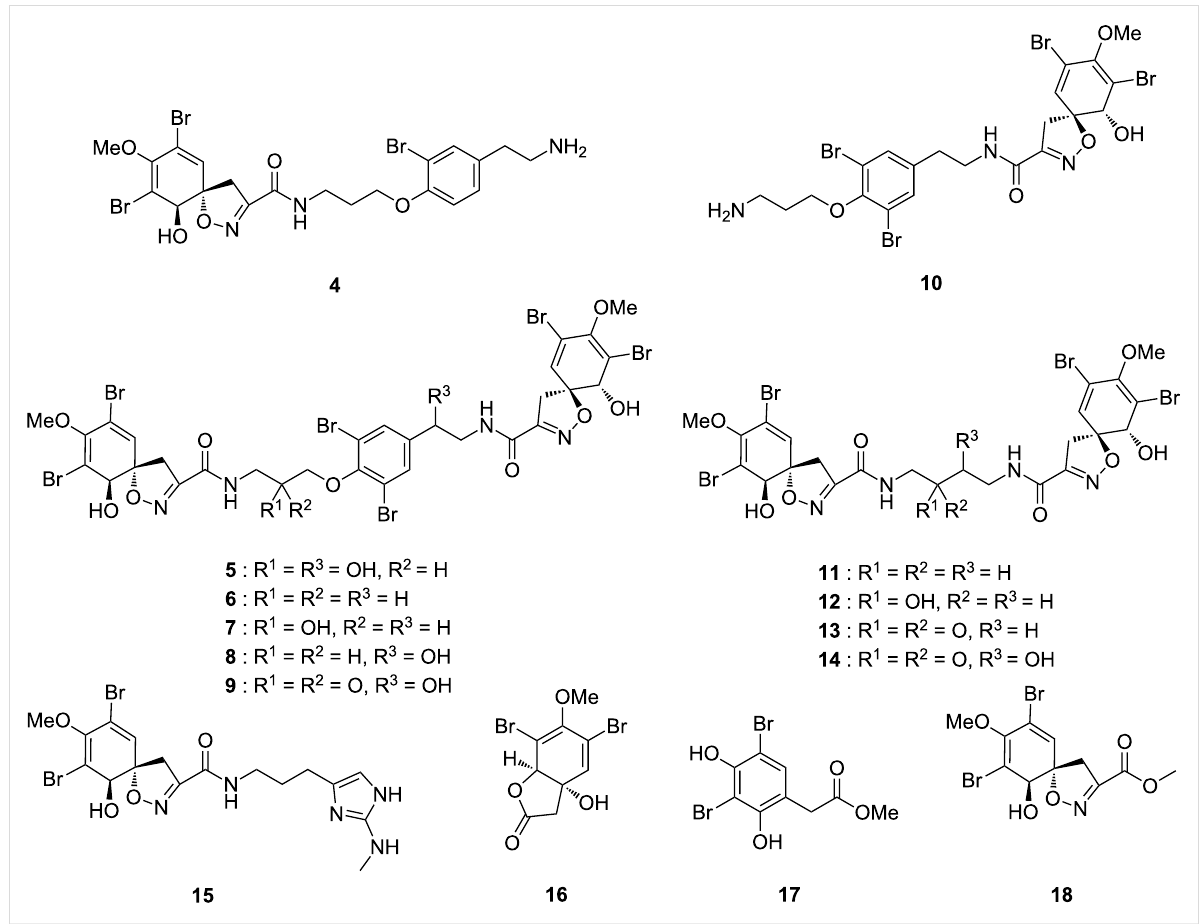
Figure 2: Bromotyrosine alkaloids and brominated compounds isolated from the sponge Aplysina lacunosa .